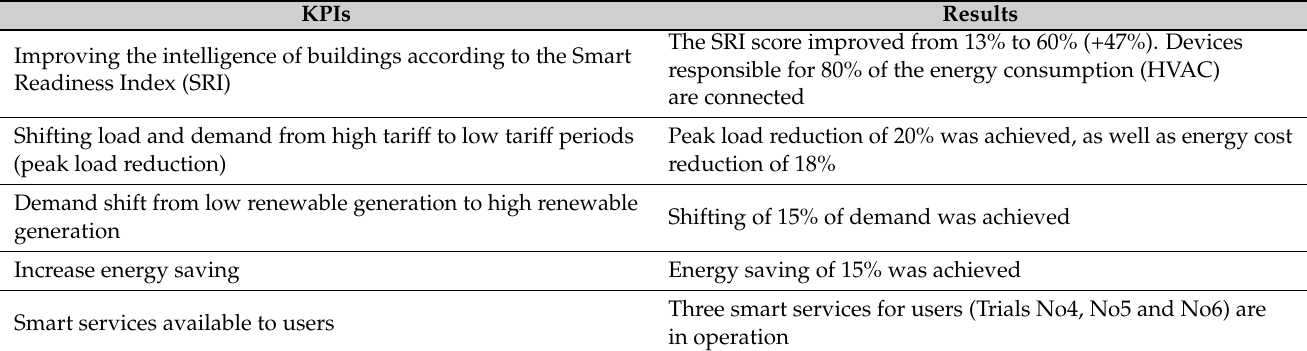
Table 8. KPIs demonstration in